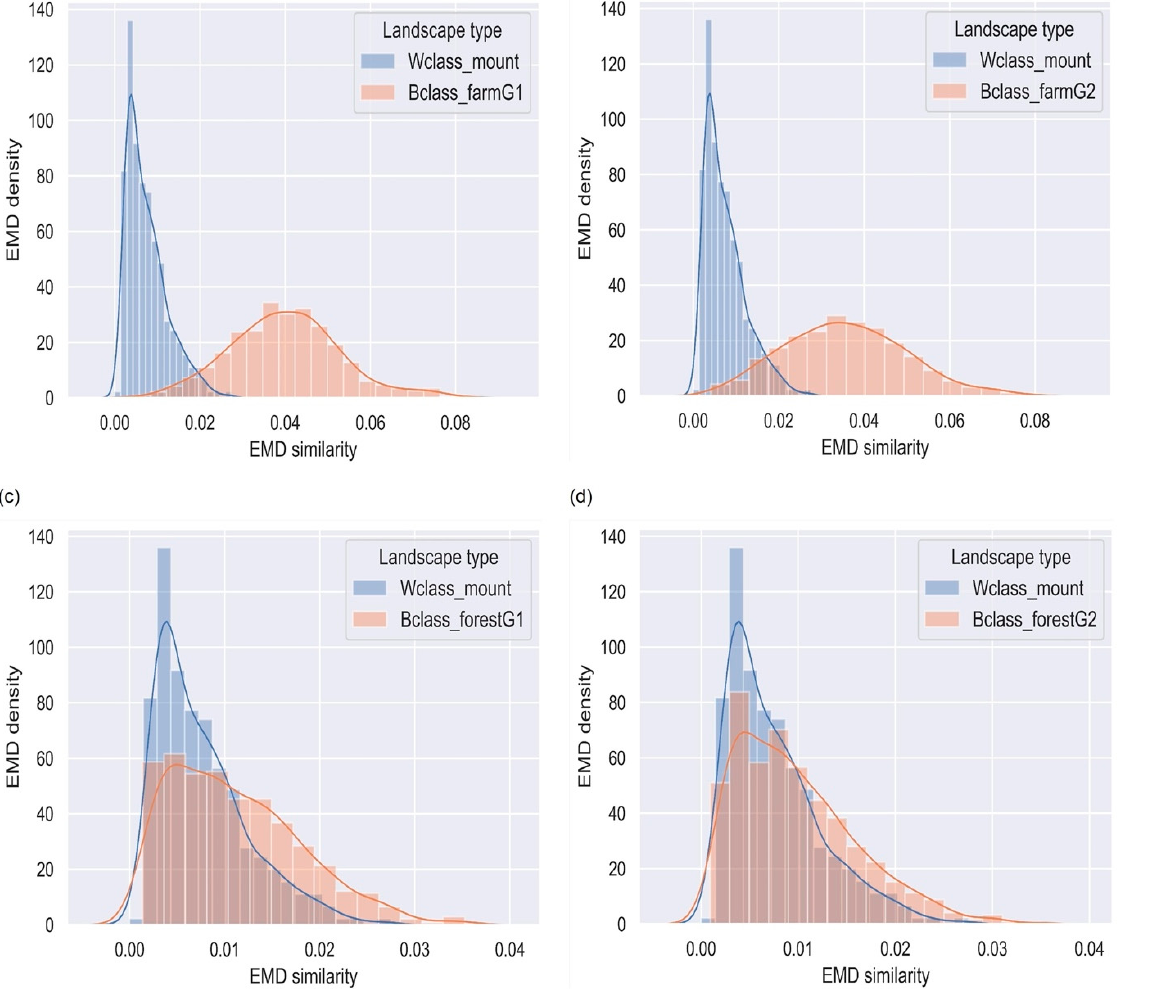
Figure 9. Landscape similarity comparison. EMD similarity distribution for mountain, forest, and farm patterns is depicted in ( a – d ). Mountain feature map comparison is within-class (i.e., mountain vs. mountain). Between-landscape type similarity distribution is derived through mountain vs. farm ( a , b ), and mountain vs. forest comparisons ( c , d ).